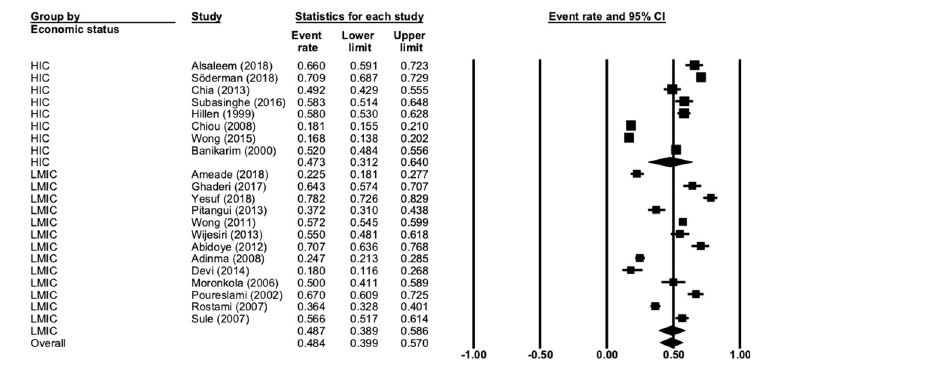
Fig 3. Pharmacological analgesia use.